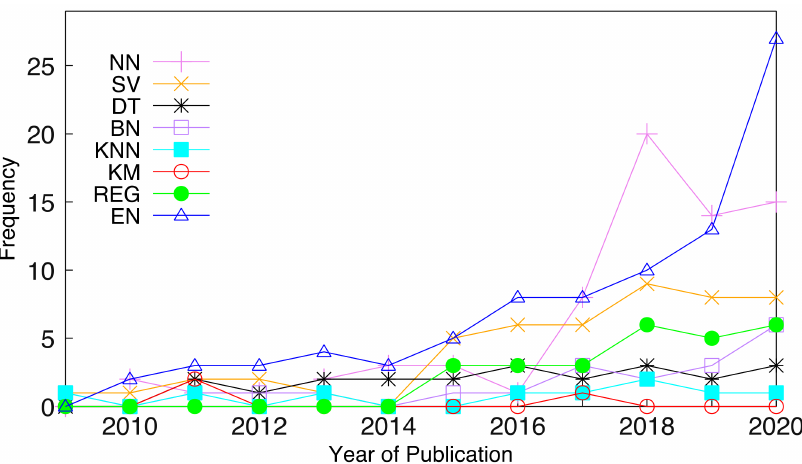
Figure 7. ML techniques covered by all